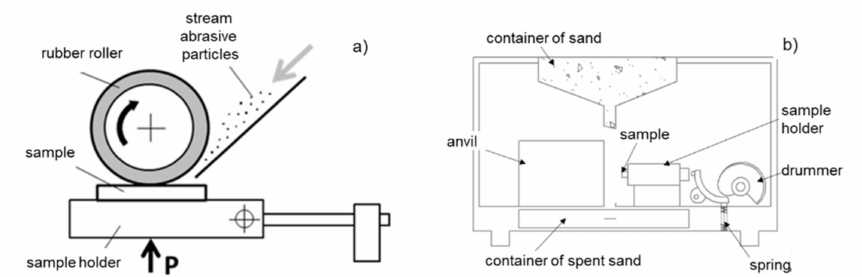
Figure 3. The experimental test stand for testing of samples: ( a ) abrasive wear according to the “rotating roller–flat surface” scheme; ( b ) impact and abrasive wear.